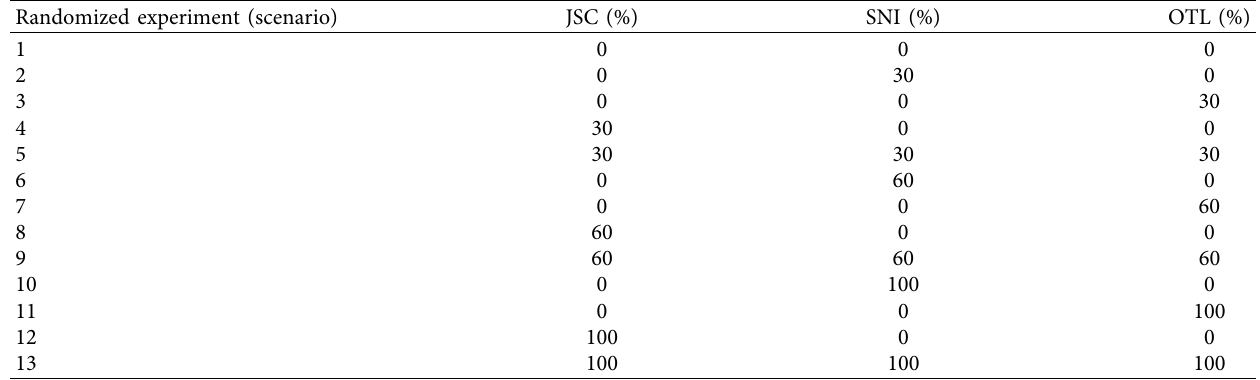
Table 8: Fractional factorial design of experiments.